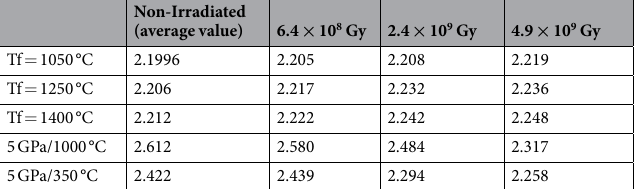
Table 1. Density values of the different Suprasil samples obtained either after a 5 GPa hot compression at 350 °C and 1000 °C or a T f treatment (T f = 1050, 1250 and 1400 °C) and their evolution under irradiation for different integrated doses.